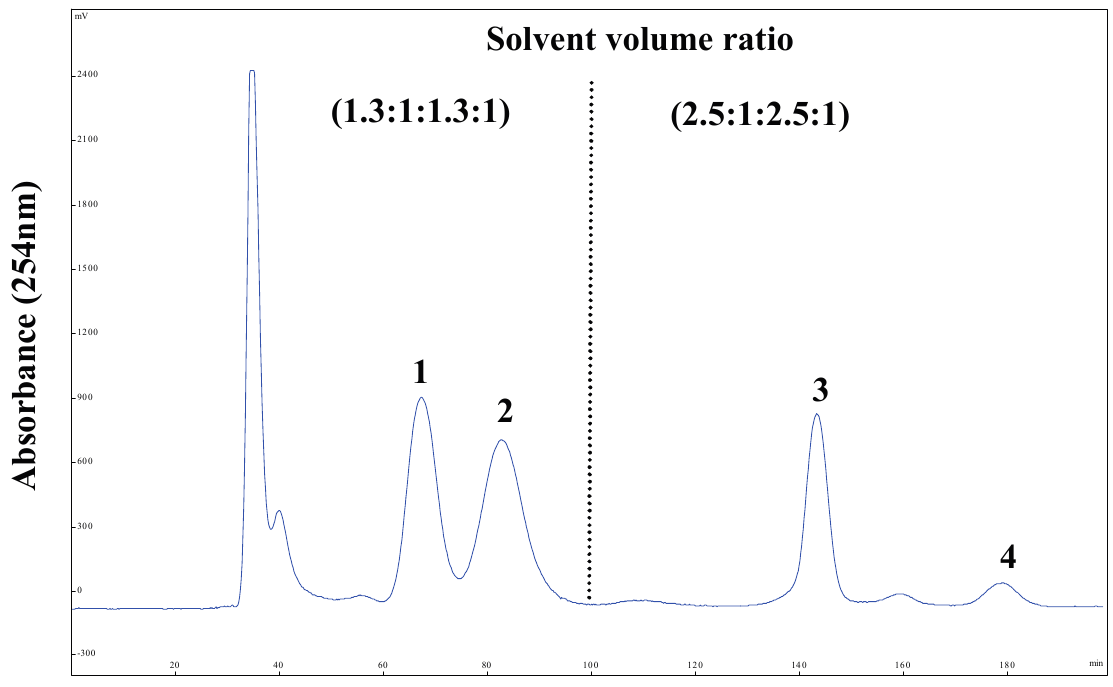
Figure 3. HSCCC chromatogram of the crude extract from J. procumbens using stepwise elution with solvent systems A and B. Solvent system A: n -hexane-ethyl acetate-methanol-water (1.3:1:1.3:1, v/v/v/v), solvent system B: n